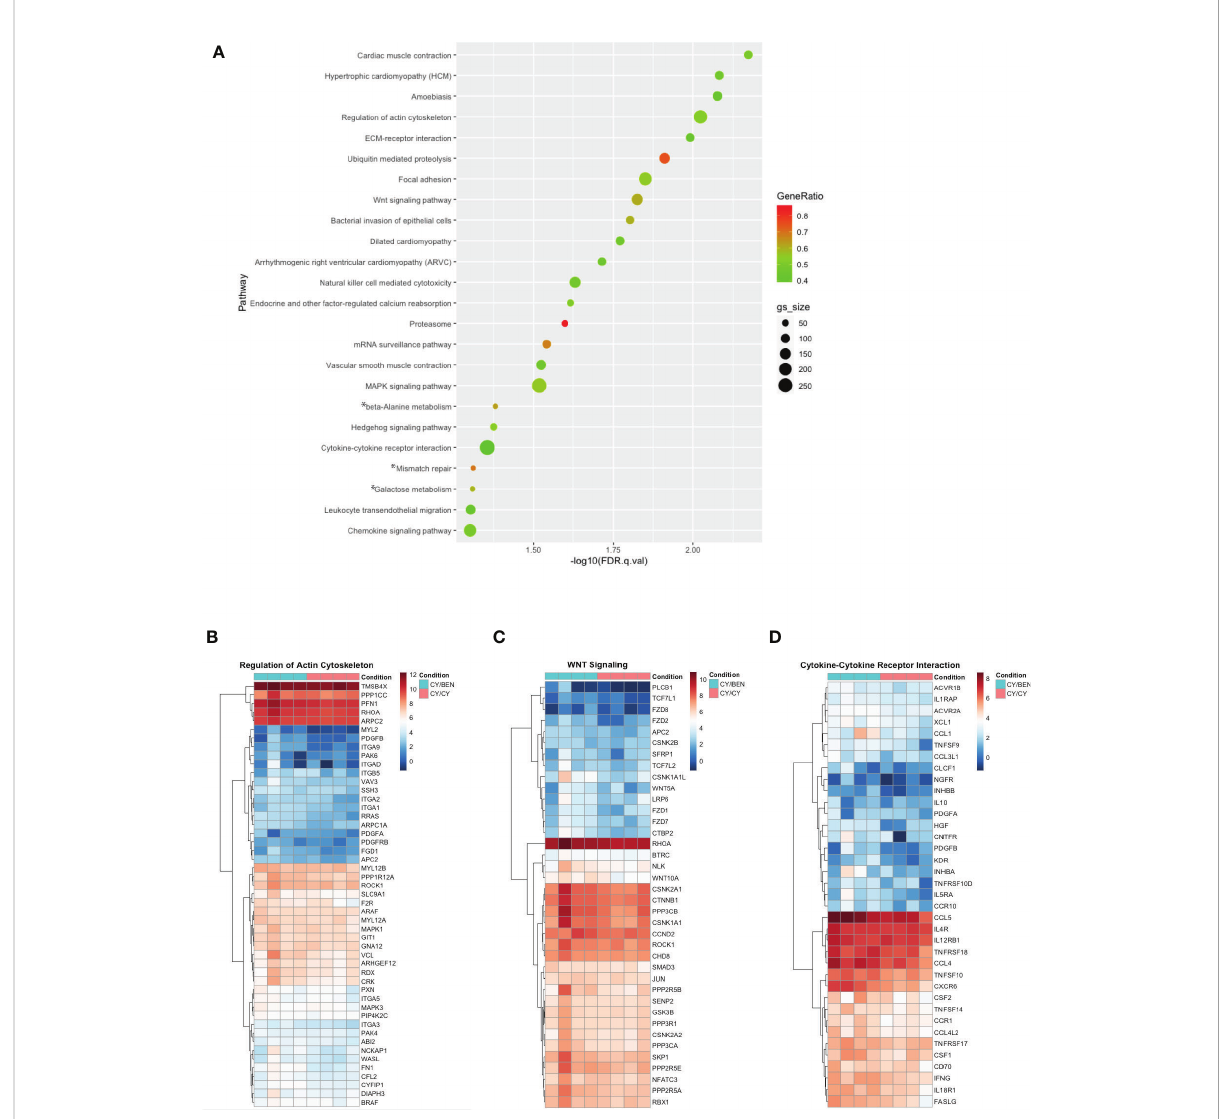
FIGURE 8 Gene set enrichment analysis annotated to KEGG terms reveals changes in multiple pathways related to cell migration, proliferation/ differentiation, and in fl ammation between CY/CY and CY/BEN groups. (A) Dot plot of signi fi cantly different KEGG terms identi fi ed via gene set enrichment analysis from transcriptomes of spleens from CY/CY and CY/BEN treated mice at day 31 following PBMC infusion. GSEA results with a q-value of q<0.05 are shown. Asterisks indicate KEGG terms with normalized enrichment scores trending positive in CY/CY treated spleens. (B-D) Heat maps illustrating differences in GSEA genes associated with speci fi c KEGG pathways were generated from log-transformed gene counts using only genes denoted as core enriched for (B) regulation of actin cytoskeleton, (C) Wnt signaling, and (D) cytokine-cytokine receptor